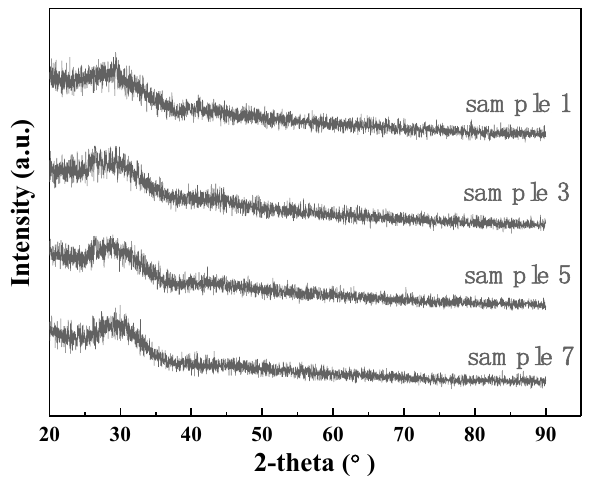
Figure 2. The XRD pattern of quenched slags.